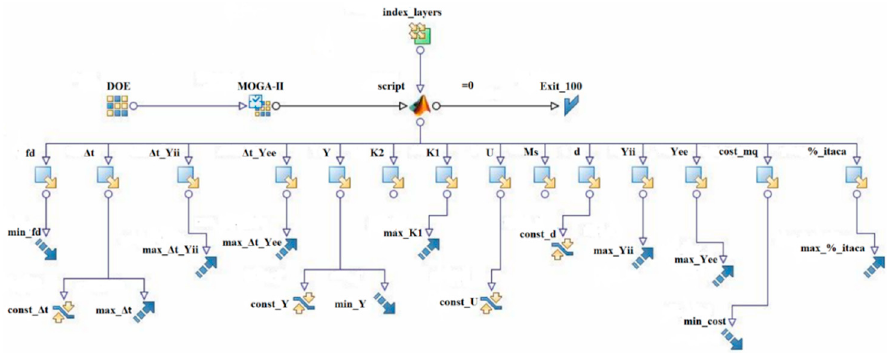
Figure 1. Flow-chart of the multi-objective analysis.